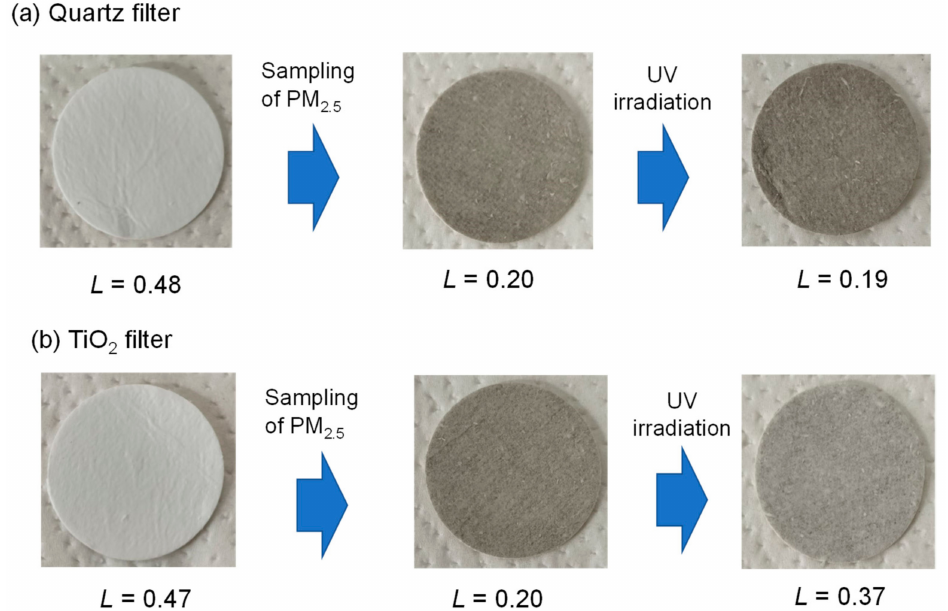
Figure 6. Changes in the relative luminance ( L ) of the PM 2.5 samples collected on the ( a ) quartz and ( b ) TiO 2 filters before sampling, after sampling/before UV irradiation, and after UV irradiation for 24